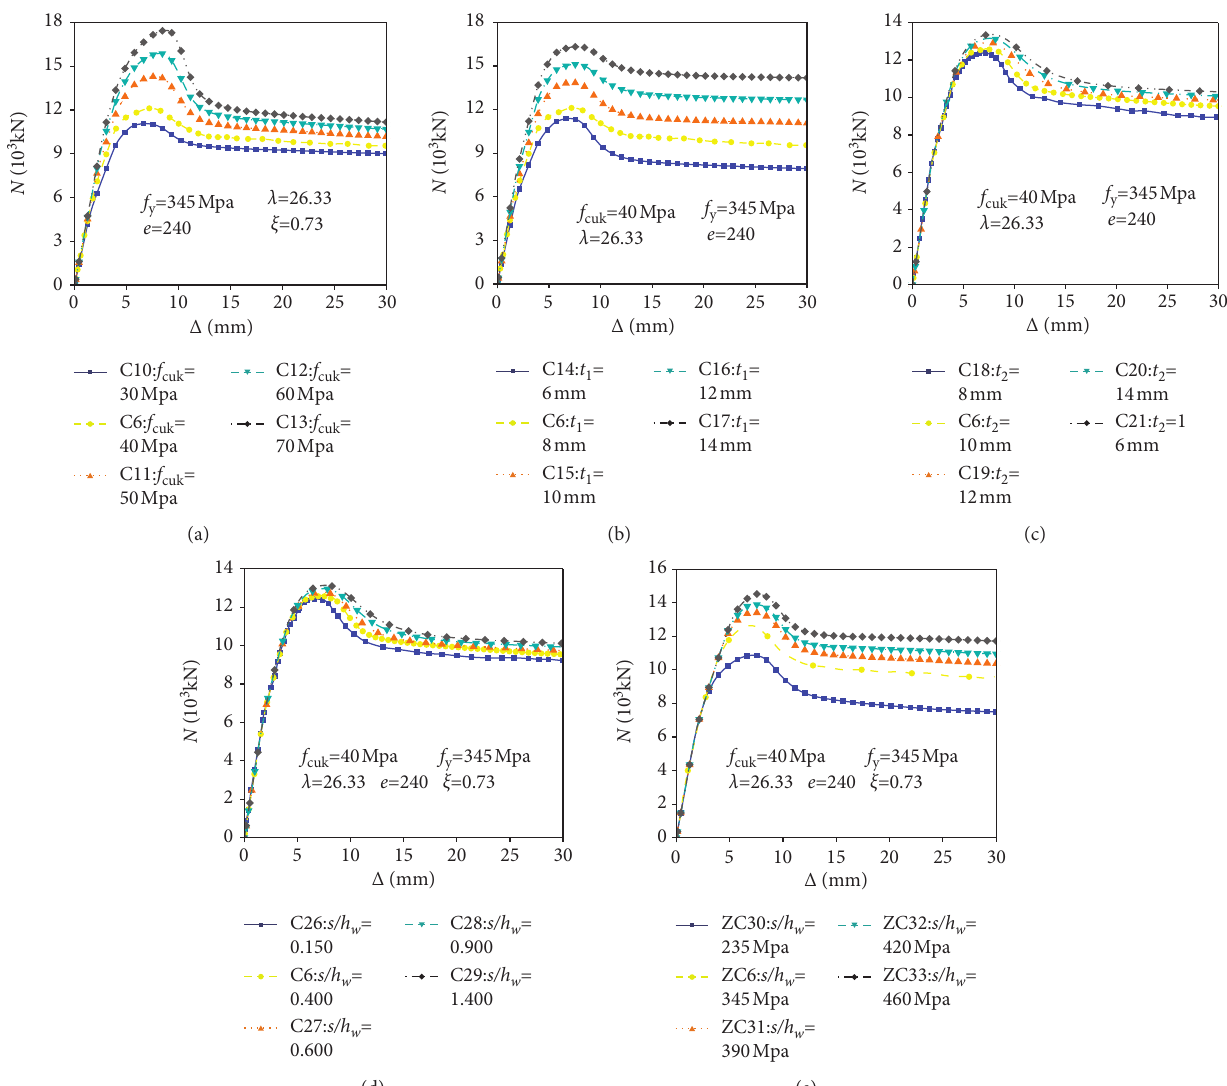
Figure 7: Comparisons of N - Δ curves of STHCCs with different parameters. (a) f